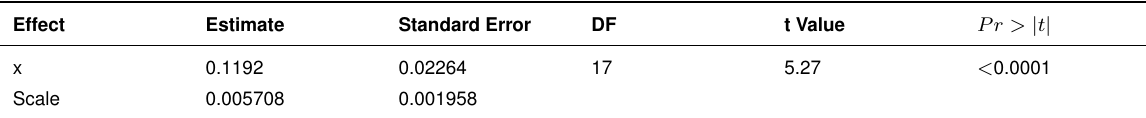
Table A1. Parameter